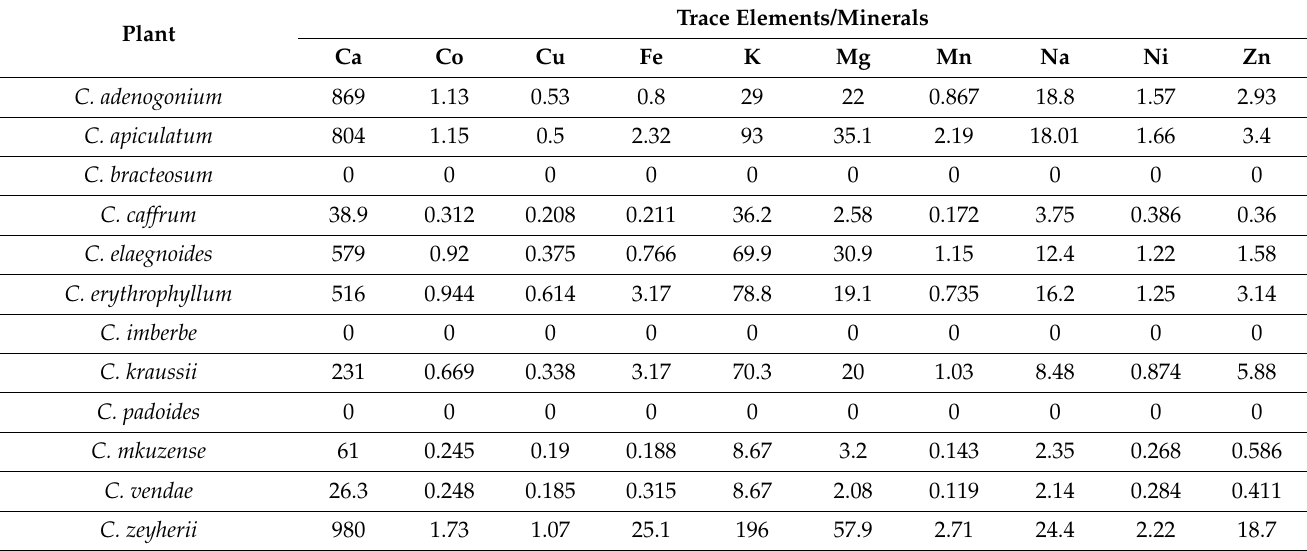
Table 7. Concentration (mg/mL) of trace minerals in the ashes of some Combretum species.